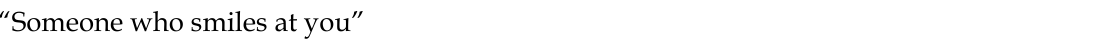
Table 3: Ways of describing basic empathy